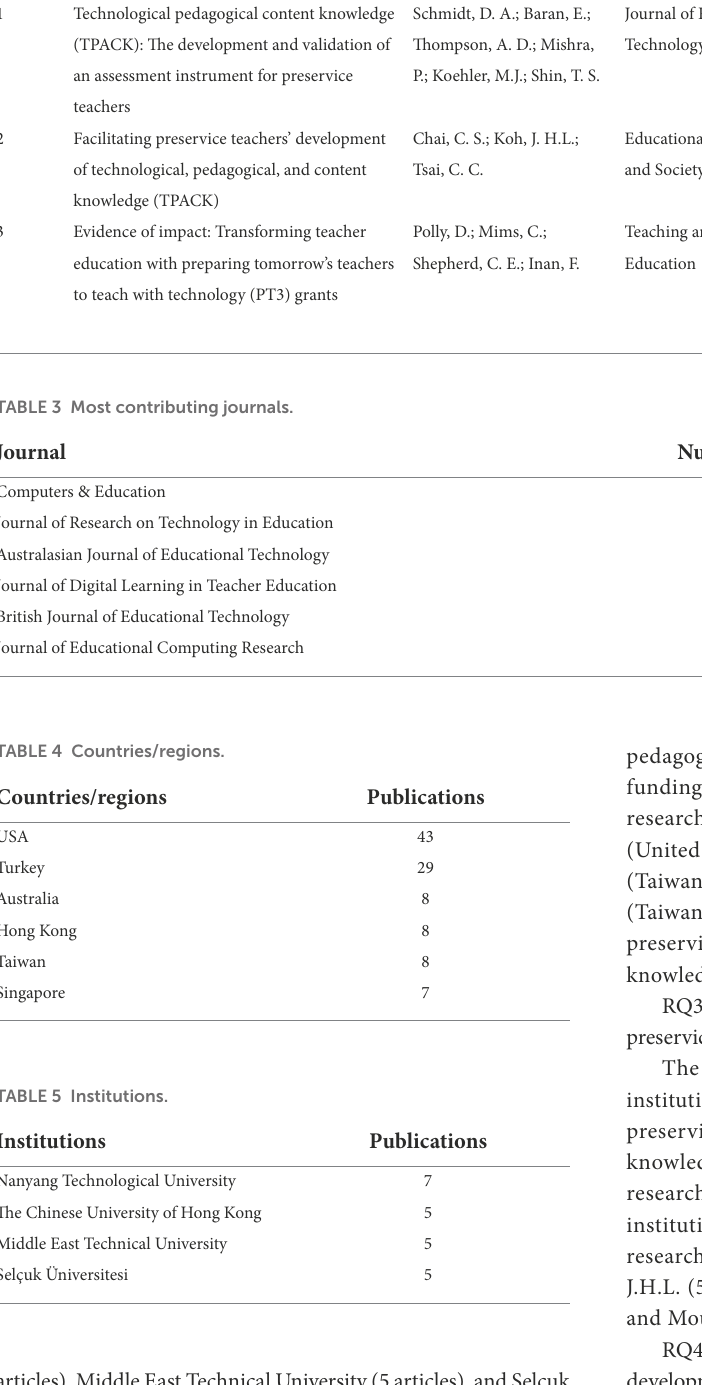
TABLE 2 The most cited publications for TPACK in preservice teacher research. Rank